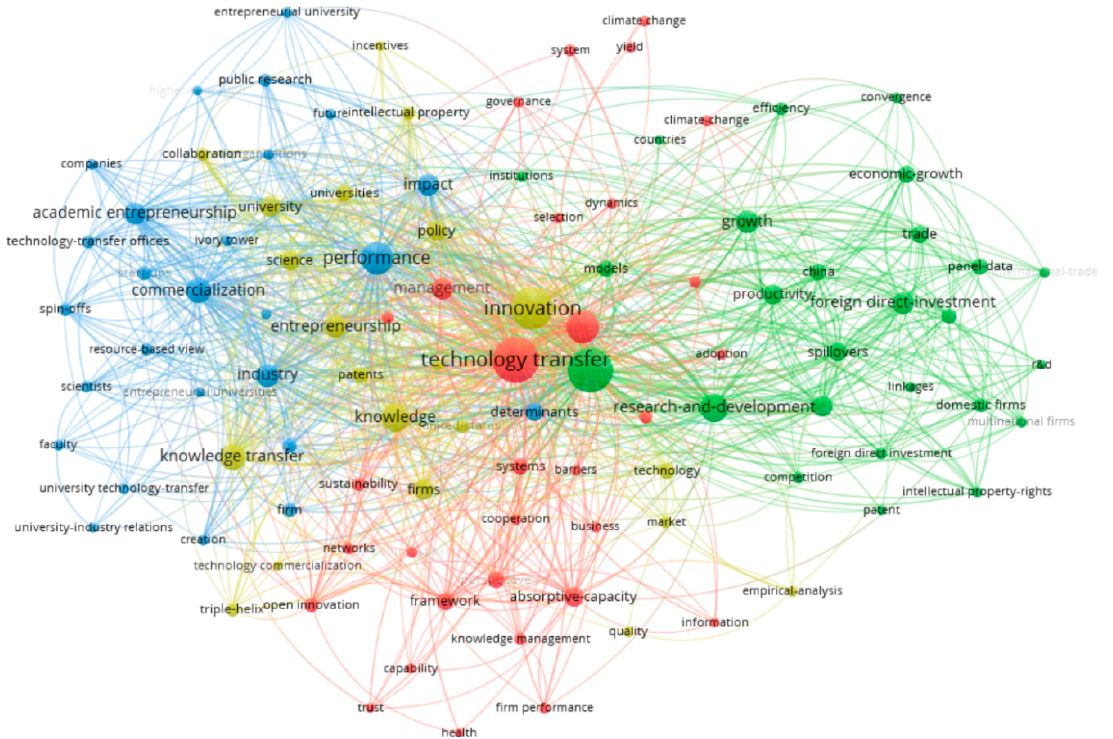
Figure 4. Topic areas in technology transfer models in 2015–2019 according to Web of Science.